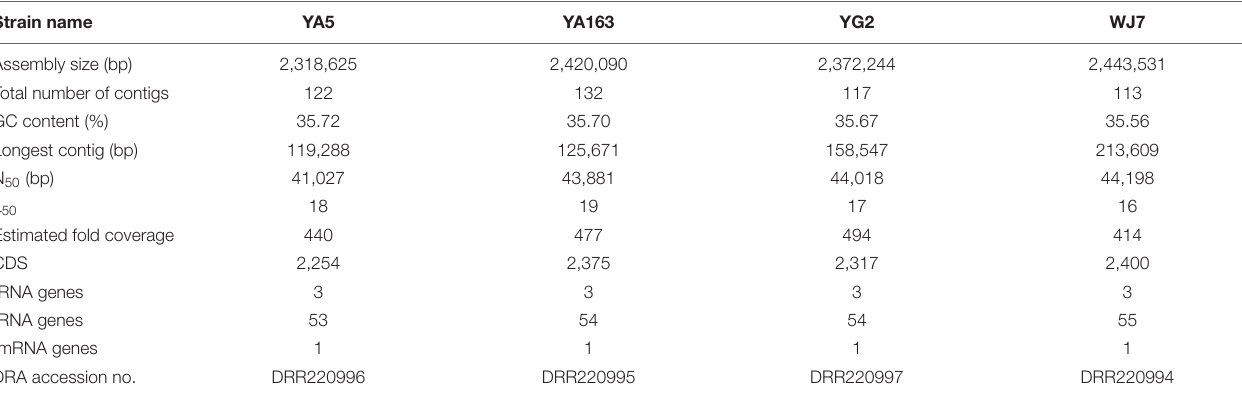
TABLE 1 | Characteristics of whole genome sequences of the four Tetragenococcus halophilus strains assembled in this